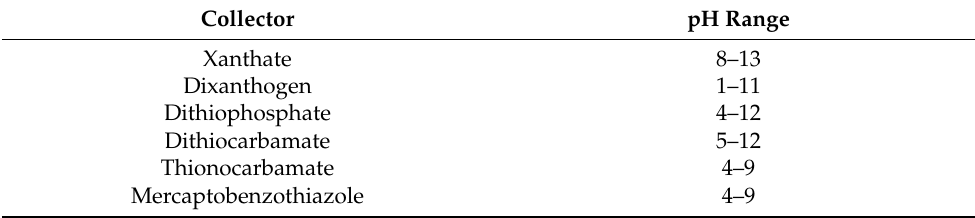
Table 2. Stability pH of hydrogen sulfide collectors.